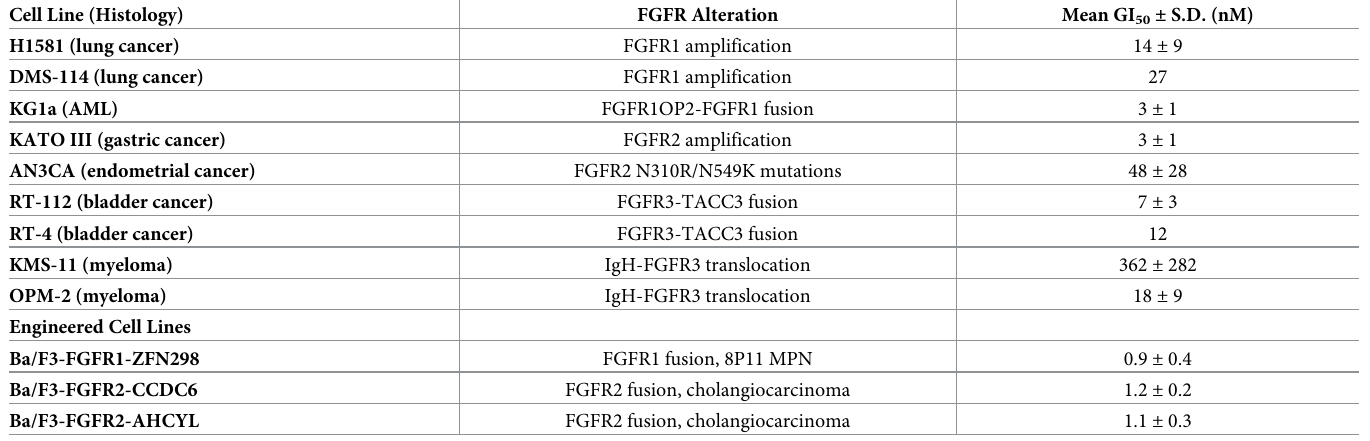
Table 1. Growth inhibition of tumor cell lines with activation of FGFR signaling by INCB054828. Cell Line (Histology)